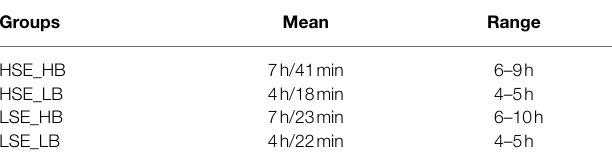
TABLE 1 | Exposure to background TV.